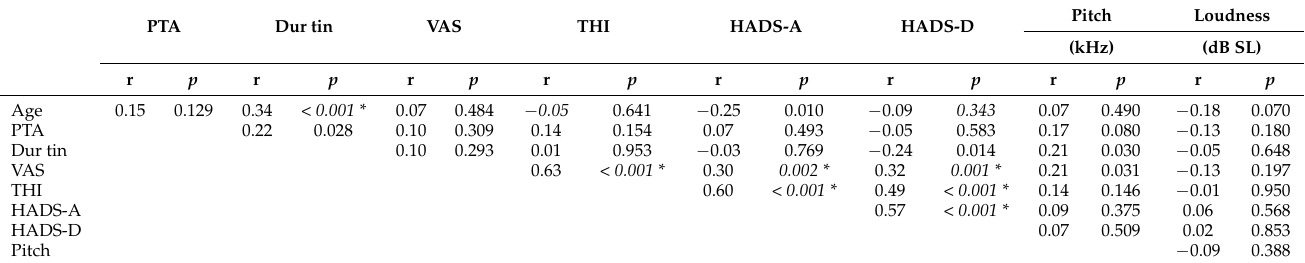
Table 4. Top: Results of Pearson correlations for pre-treatment measures among age at testing, duration of tinnitus (Dur tin), VAS scores, THI scores, HADS-A scores, HADS-D scores, tinnitus pitch match, and tinnitus loudness match across all participants ( n = 104). PTA Dur tin VAS THI HADS-A HADS-D